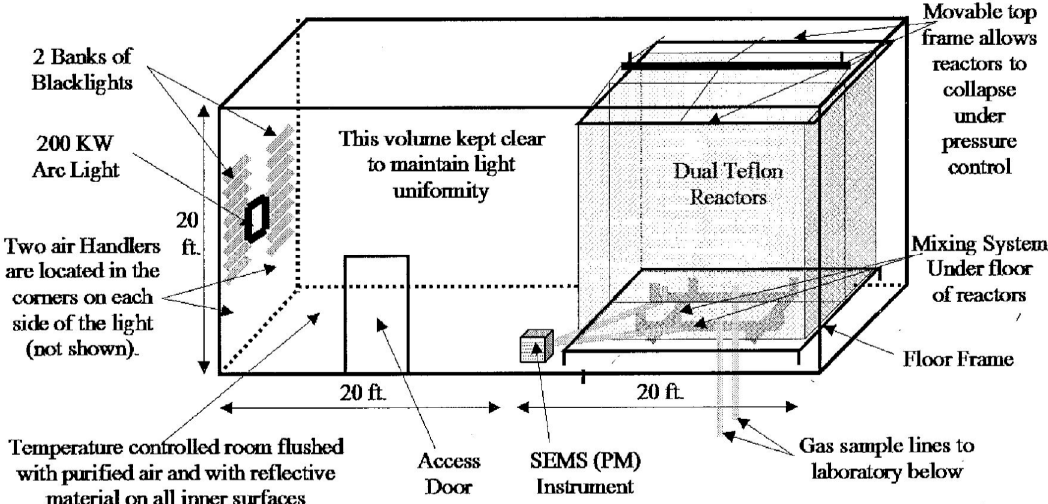
Figure 1. Example of Indoor Smog Chamber Configuration for the study of gas and aerosol photochemistry. CE-CERT, University of California Riverside System and the US Environmental Protection Agency (Reprinted from Carter et al., [85] with permission from Elsevier).